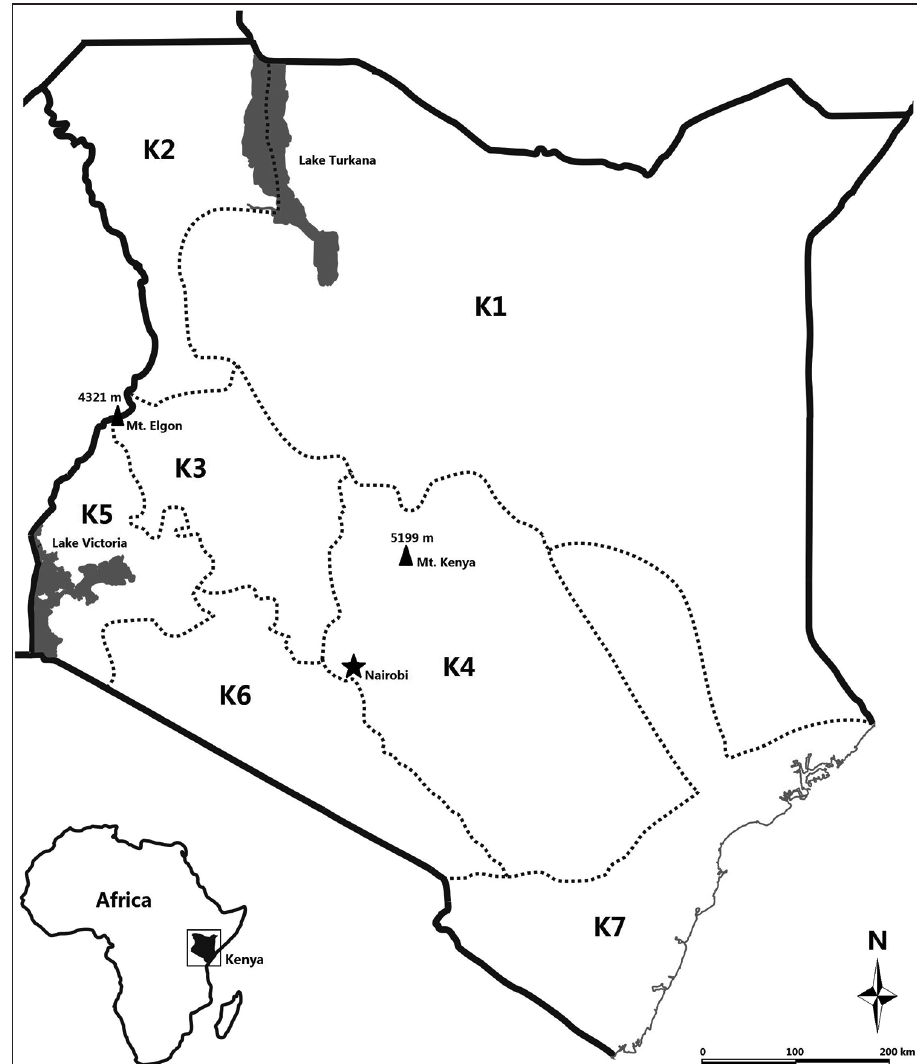
Figure 1. Kenya and its location. K1–K7 indicates plant distribution regions in "Flora of Tropical East Africa" (FTEA editors